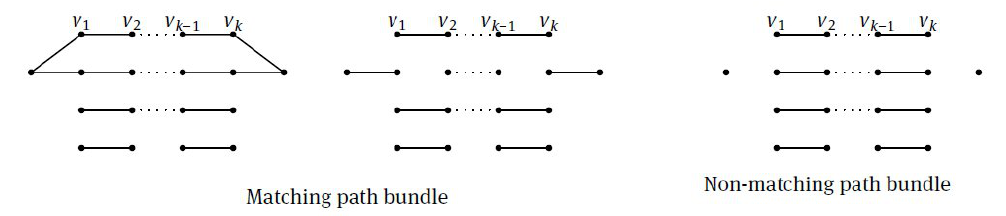
Fig. 5. Elementary linear subgraphs in Matching and Non-matching path